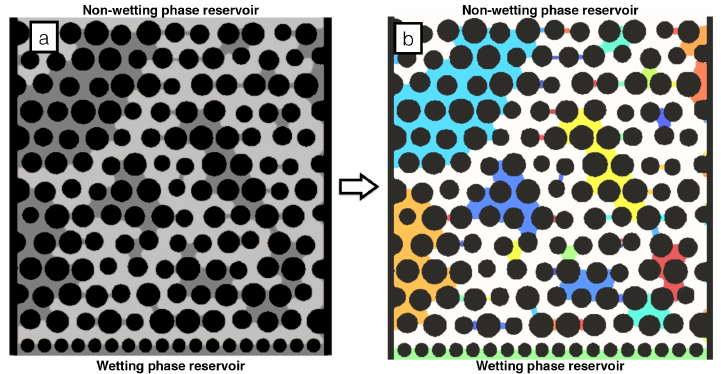
Figure 3. Phase connectivity has a direct impact on the meaning of the macroscale experimental measurements: (a) experimentally observed phase configuration corresponding to irreducible wetting-phase saturation, and (b) connected components analysis shows all wetting phase that remains in the system is disconnected from the wetting-phase reservoir. The black denotes the solid phase, the gray and various colors denote the wetting phase, and the white denotes the non-wetting